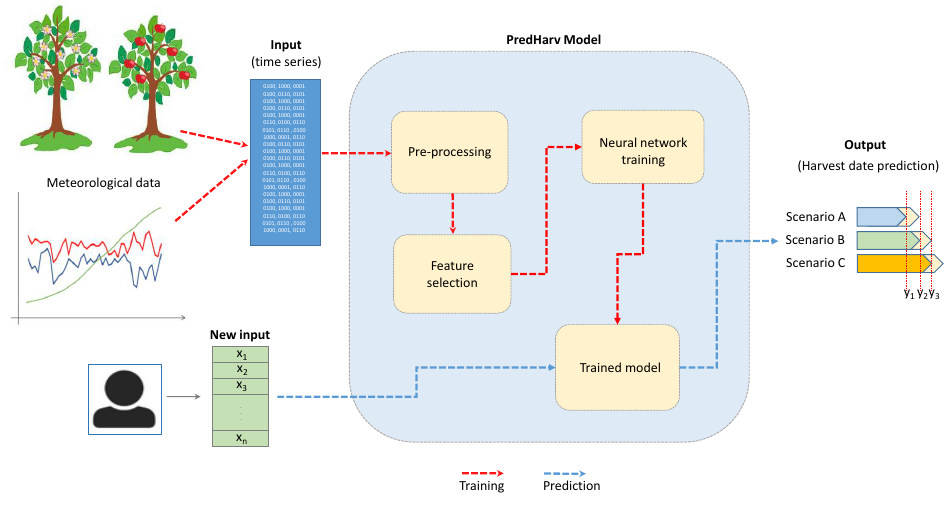
Figure 2. PredHarv model